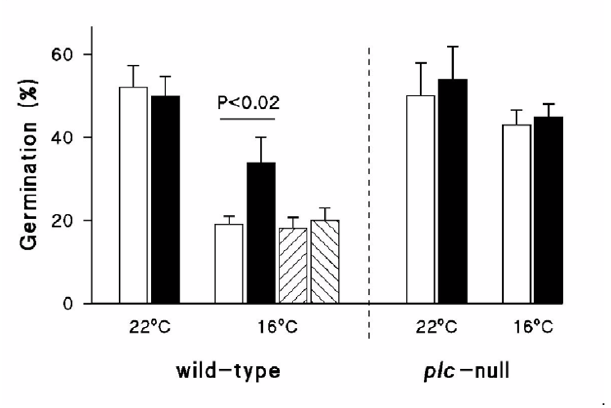
Figure 4 The effect of IP 3 on spore germination. Wild-type and plc -null spores were incubated in growth medium at 22 ° C or 16 ° C in the absence (open bars) or presence of 100 µ M Ins(1,4,5)P (filled bars); the experiment of wild-type cells at 3 16 ° C includes two controls (hached bars) with 100 µ M inosi- tol and Ins(1,3,4,)P 3 , respectively. The fraction of germinated spores was determined after 7 hours. The means and stand- ard deviations of triplicate determinations from two inde- pendent experiments are shown. The effects of additives are not significant except for Ins(1,4,5)P 3 at 16 ° C in wild-type